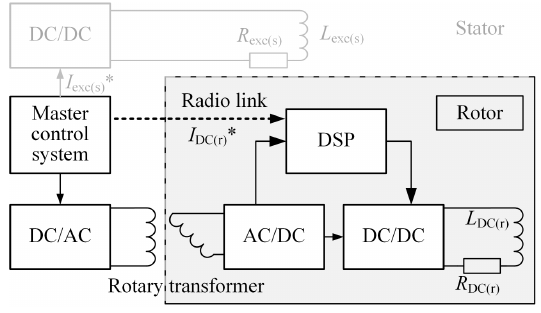
Figure 9. Power supply system.